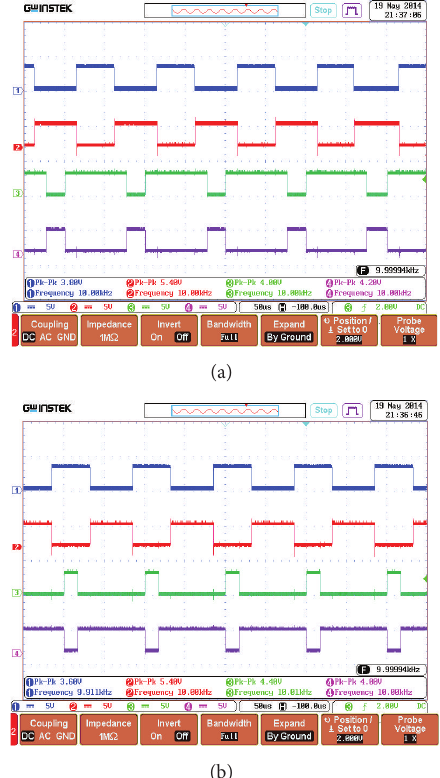
Figure 13: PWM duty cycle generation for fuzzy-PID controller signals.